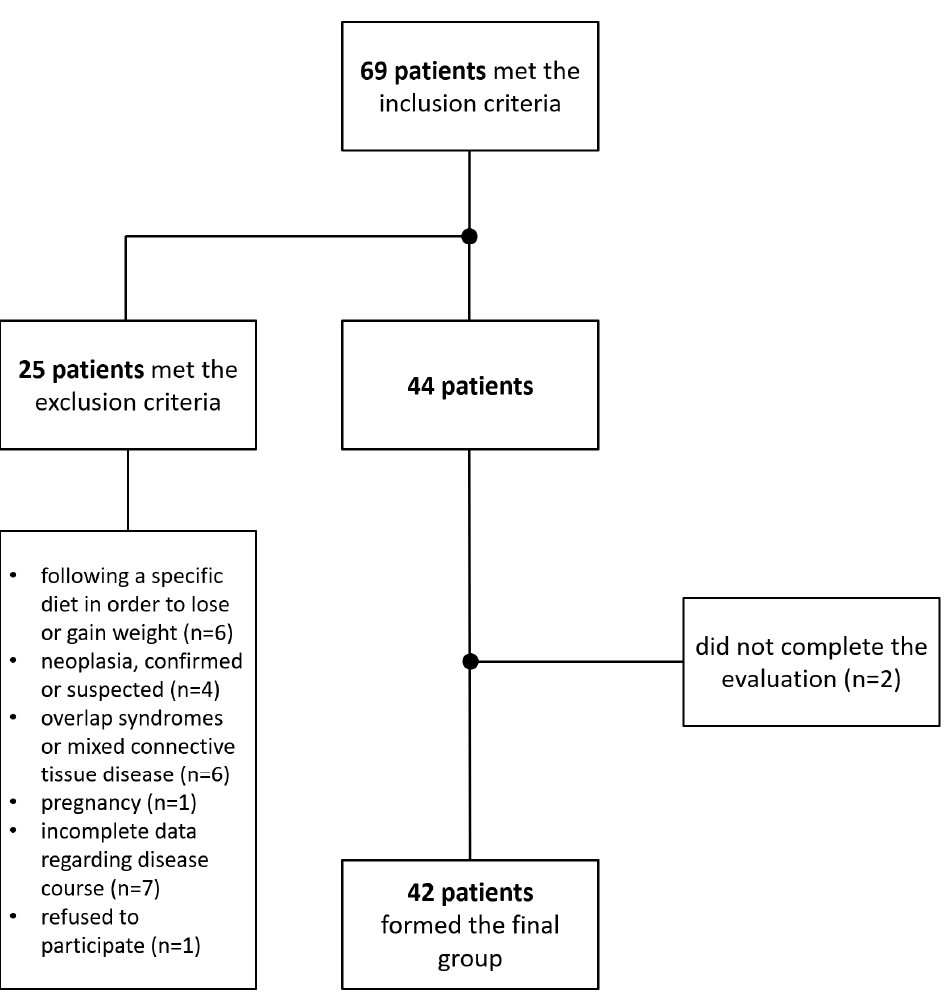
Figure 1. Flow diagram of the inclusion and exclusion processes leading up to the final study group.